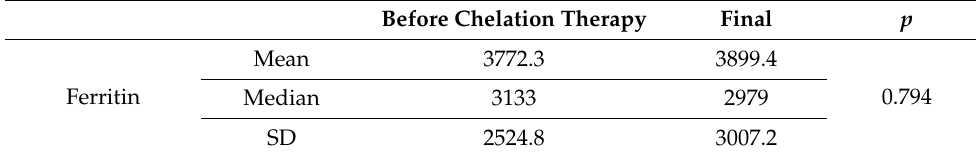
Table 1. Comparison of ferritin levels before chelation therapy with final ferritin level. Before Chelation Therapy Final p Mean 3772.3 3899.4 Ferritin 2979 SD 2524.8 3007.2